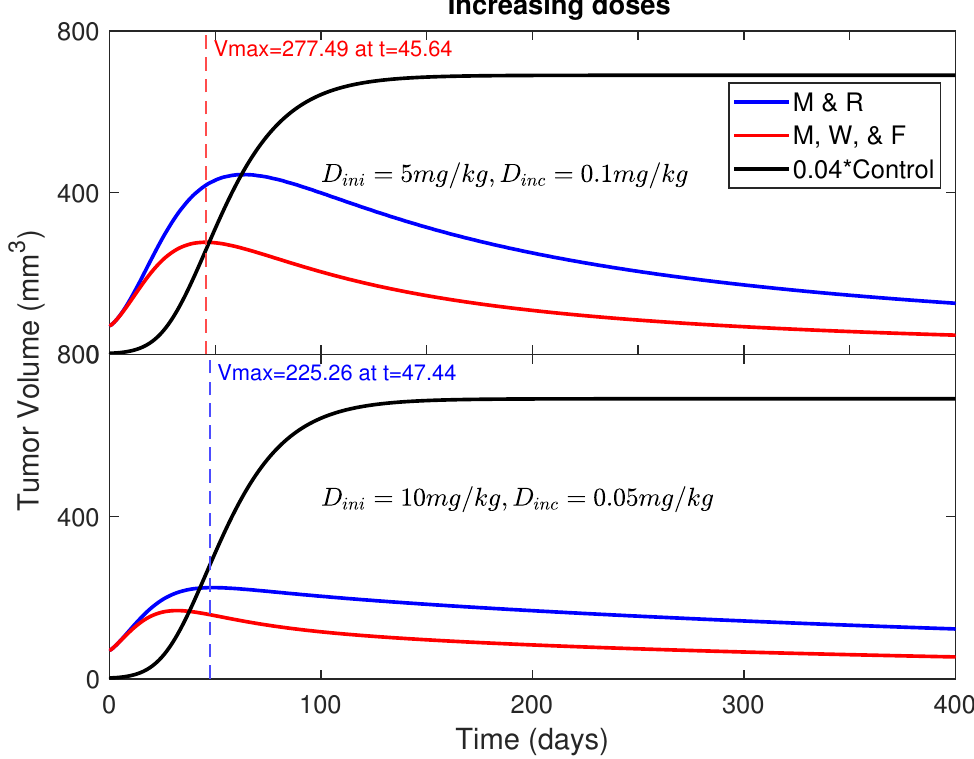
Figure 2. A comparison of increasing dose pattern for two different starting doses D ini = 5 and 10 mg/kg and respective dose increments D inc = 0.1 and 0.05 mg/kg. Both of these dose